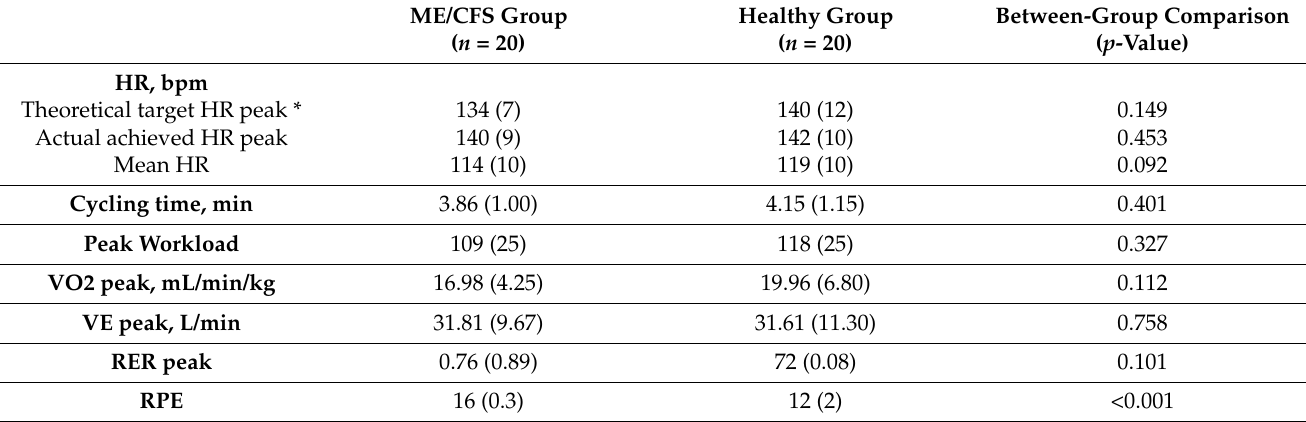
Table 2. Exercise-related outcomes.